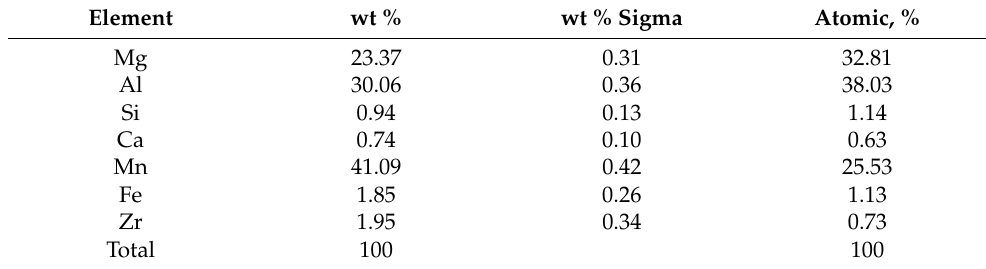
Table 5. Results of the chemical composition analysis of the AZ91 with 0.3 wt % of Zr taken at the point P1 in Figure